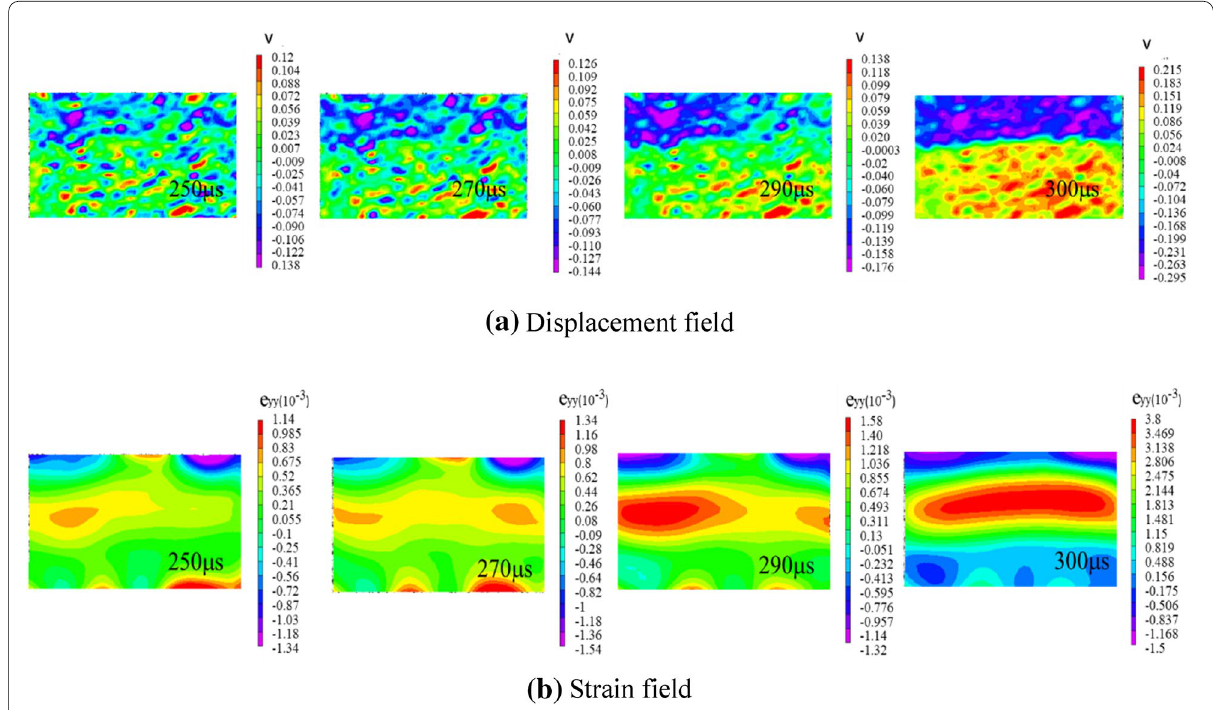
Fig. 13 DIC analysis results of